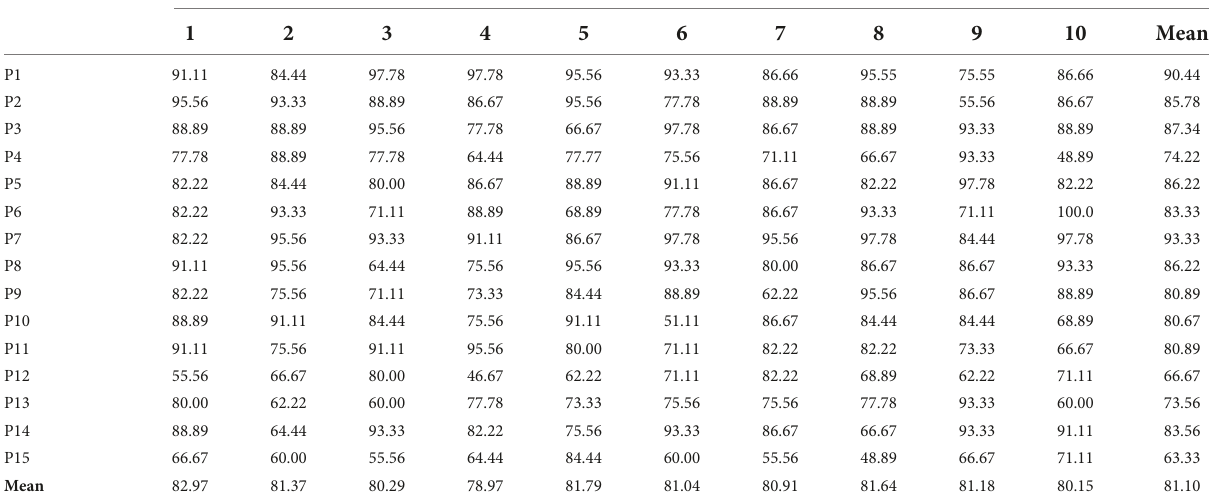
TABLE 4 Results of AR–P300 recognition in